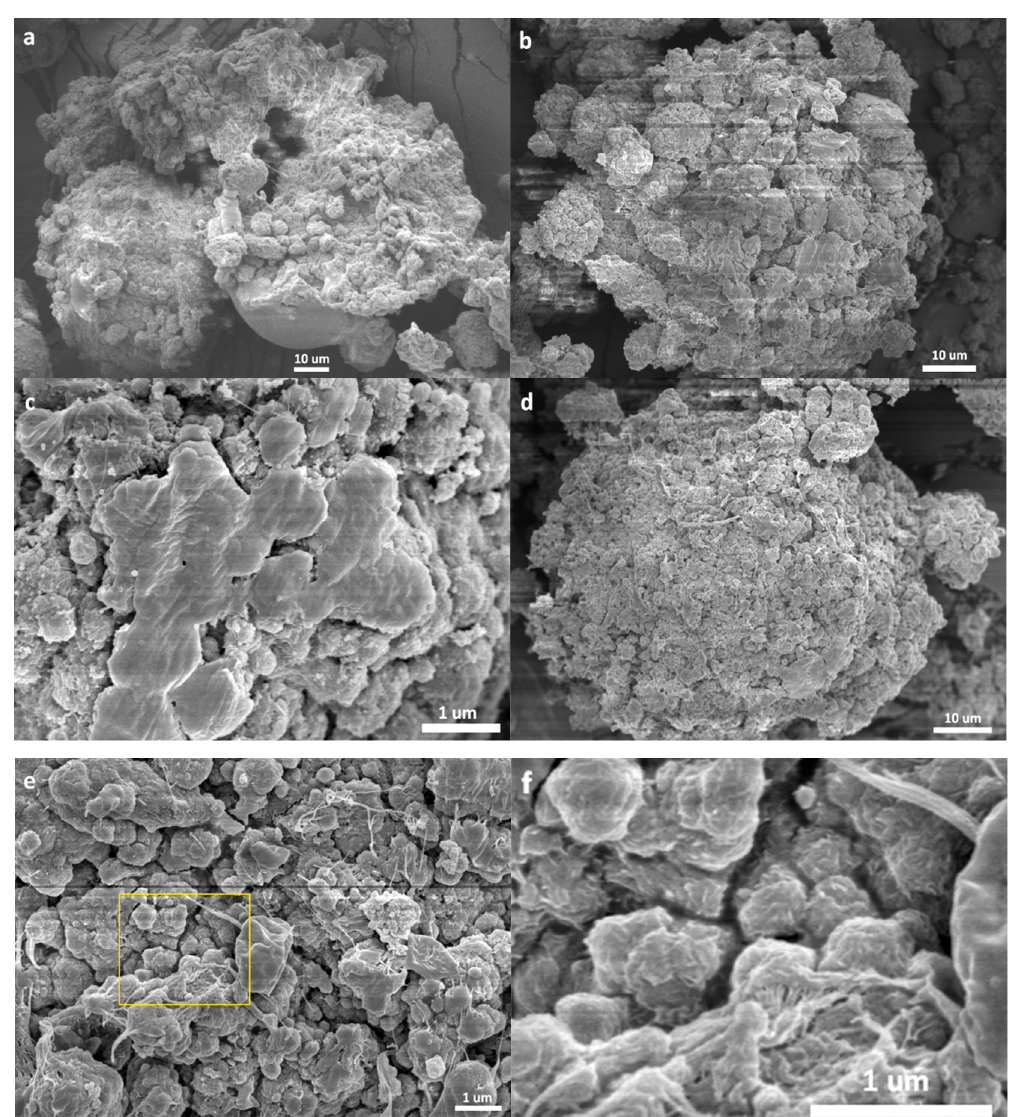
Figure 3. SEM pictures of PE/catalyst particles formed at different polymerization times: ( a ) 60 s; ( b , c ) 120 s; ( d – f ) 180 s (samples E2, E3, and E4 in Table 1. The enlarged picture of the marked area in ( e ) is shown in ( f )).